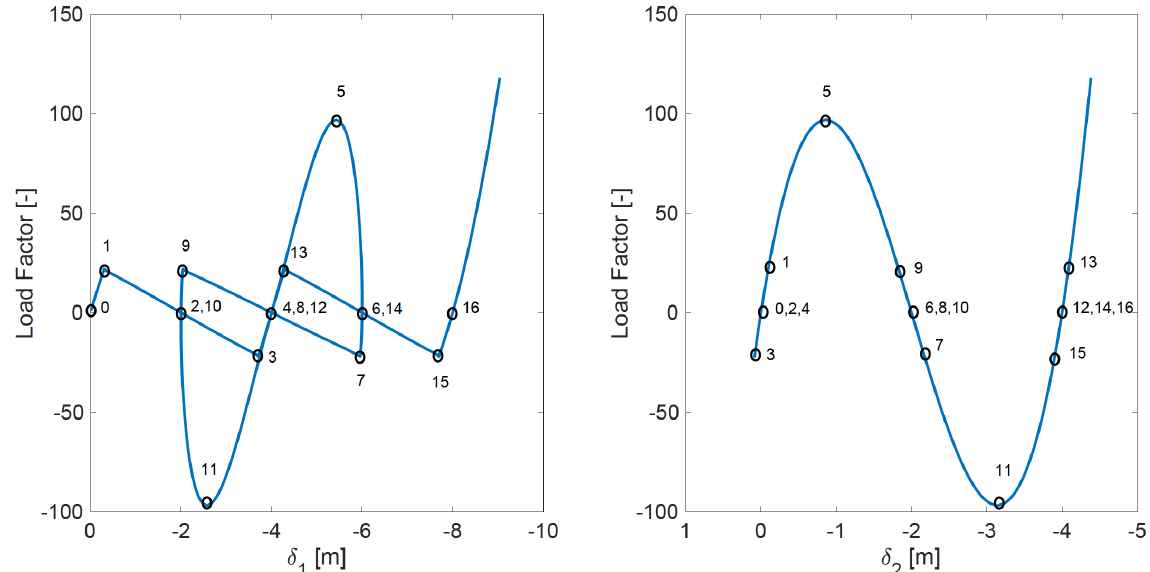
Figure 11: Sixteen-member structure load-displacement curves (Case 2 – λ up = 36.7